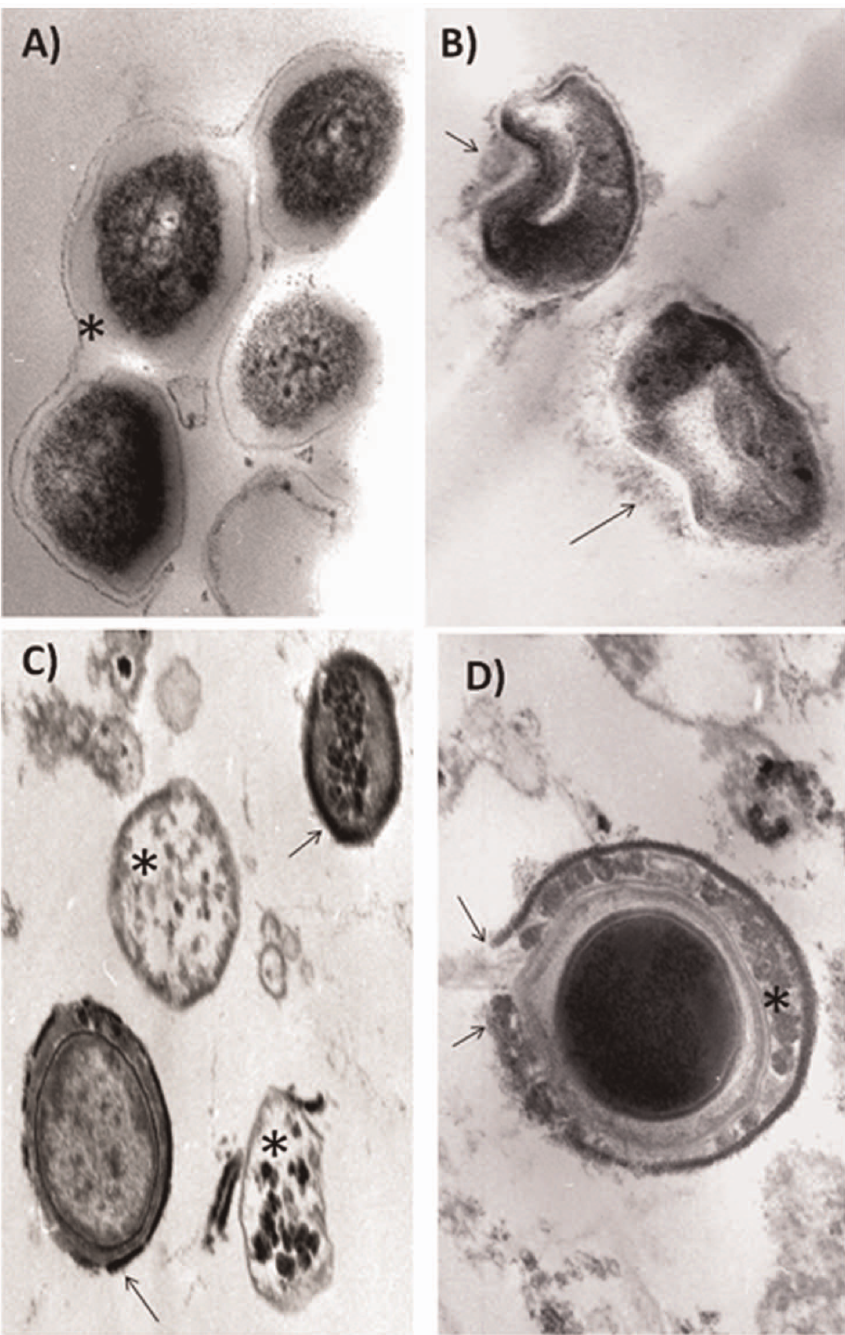
Figure 3. Representative electron microscopy micrographs of Mycobacterium tuberculosis strain H37Rv treated with high concentrations of IDR peptides. (A) Control bacteria show thick homogeneous electron lucent cell wall (asterisk) and cytoplasm with some electron dense granules (63,000x); (B) Incubation with peptide 1002 induces abnormalities in the cell wall, such as thinning, budding and partial dissolution (arrows) (100,000x). (C) Peptide HH2 induces complete disappearance of the cell wall with electron lucent cytoplasm (asterisks) or homogenous cell wall thinning and condensation (arrows) with slight electron lucent change of the cytoplasm (80,000x). (D) Incubation with peptide 1018 produced a peripheral electron dense rim with areas of rupture and dissolution (arrows) in the cell wall, which also have irregular electron dense condensations (asterisk) and an electron lucent halo around the cytoplasm (100,000x). All bars in the figures represent 5 m m. The micrographs are representative of 2 independent experiments. doi:10.1371/journal.pone.0059119.g003 lymphocytes (Fig. 5C, 5D); the pneumonic areas from mice treated cytes around blood vessels and airways (Fig. 5E, 5F). Mice treated with 1018 also showed predominant activated macrophages and with 1002 showed non-significant differences in lung area affected thick inflammatory cuffs predominantly constituted by lympho- by pneumonia (Fig. 4B).